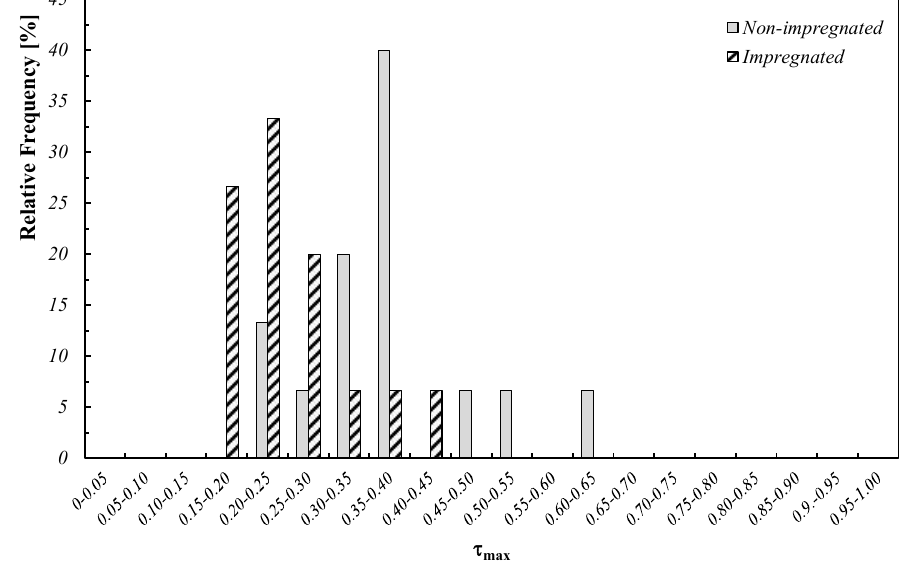
Figure 12. Frequency distribution of shear stress of non-impregnated_Y_pull-out and impregnated_Y_pull-out series of specimens.